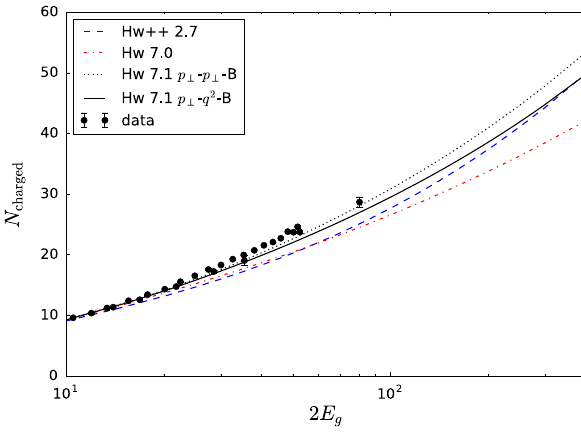
Fig. 9 The evolution of the number of charged particles in e + e − → hadrons as a function of the centre-of-mass energy